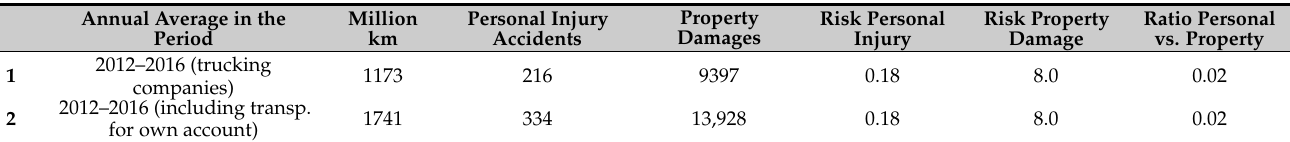
Table 6. Annual kilometres driven, personal injury accidents, and property damage accidents for HGVs driven by drivers employed in trucking companies in rental transport (58% in Row 1) and also including drivers employed in companies involved in transport for own account (90% in Row 2) in the period